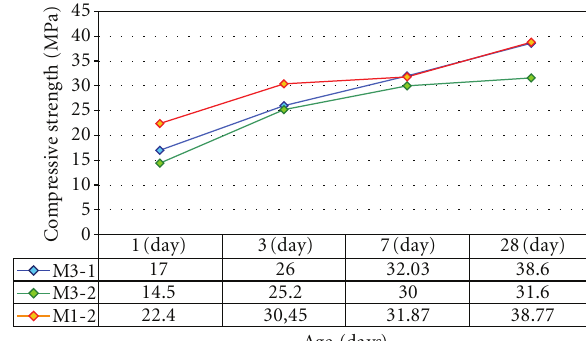
Figure 8: Compressive strength of the 2nd group.